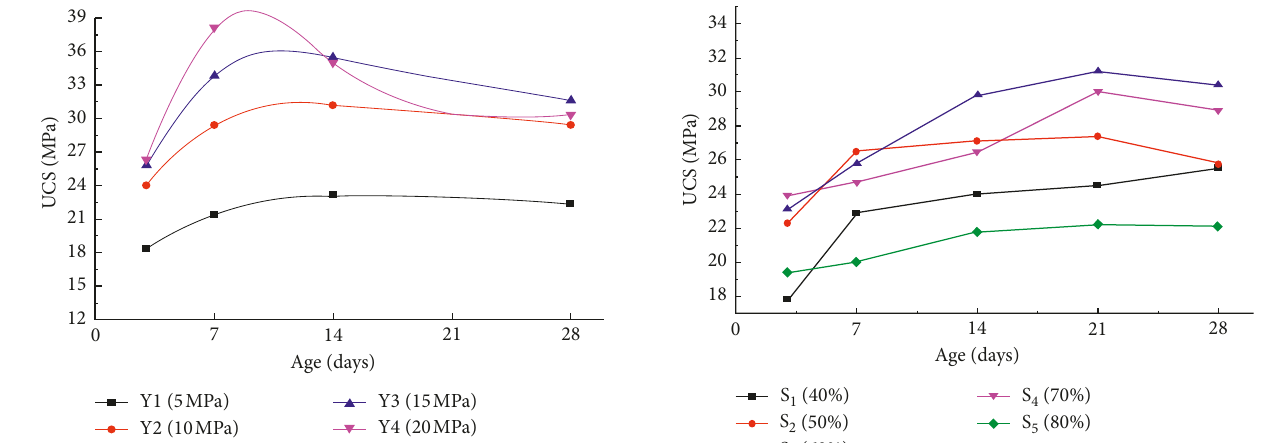
Figure 4: Compressive strength of different pressure parameters.